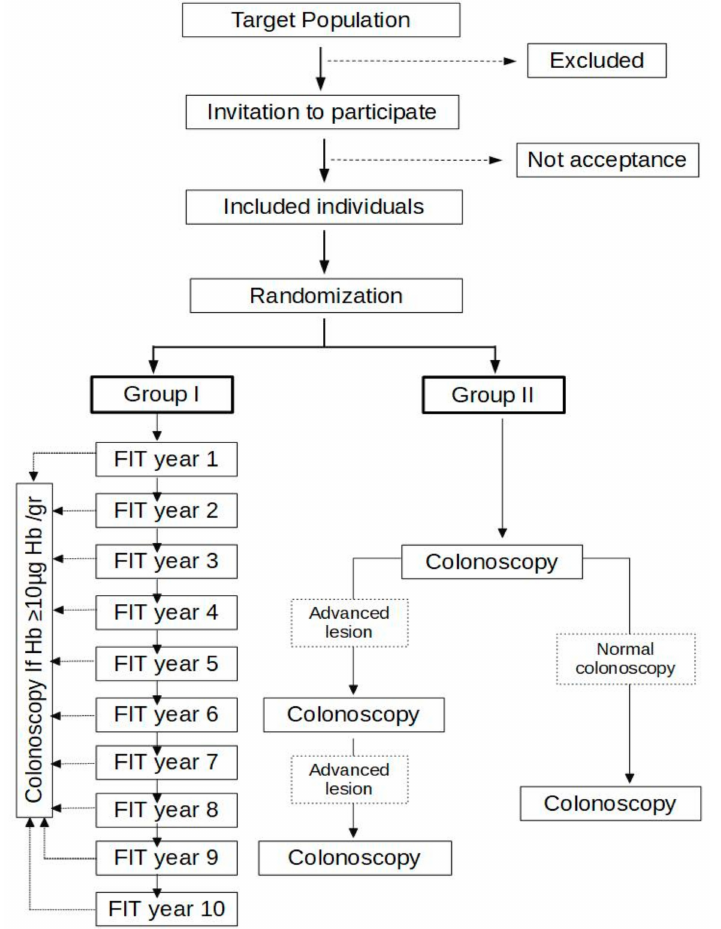
Figure 1. Diagram of the study